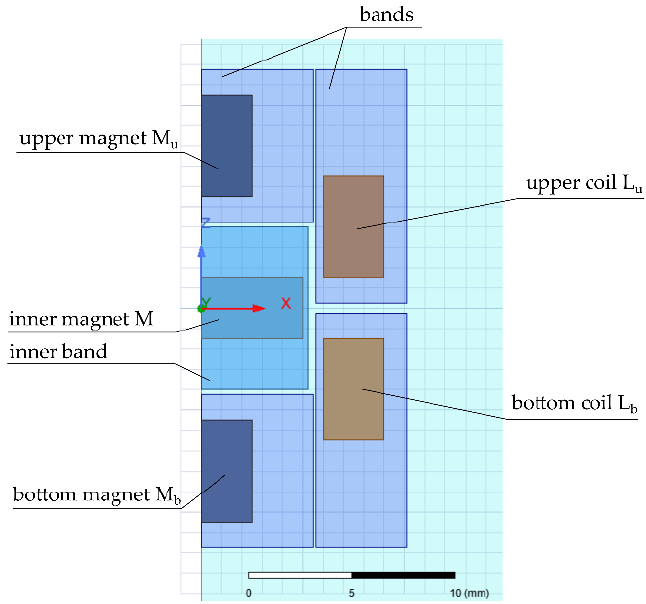
Figure 9. The FEM model of an investigated harvester.